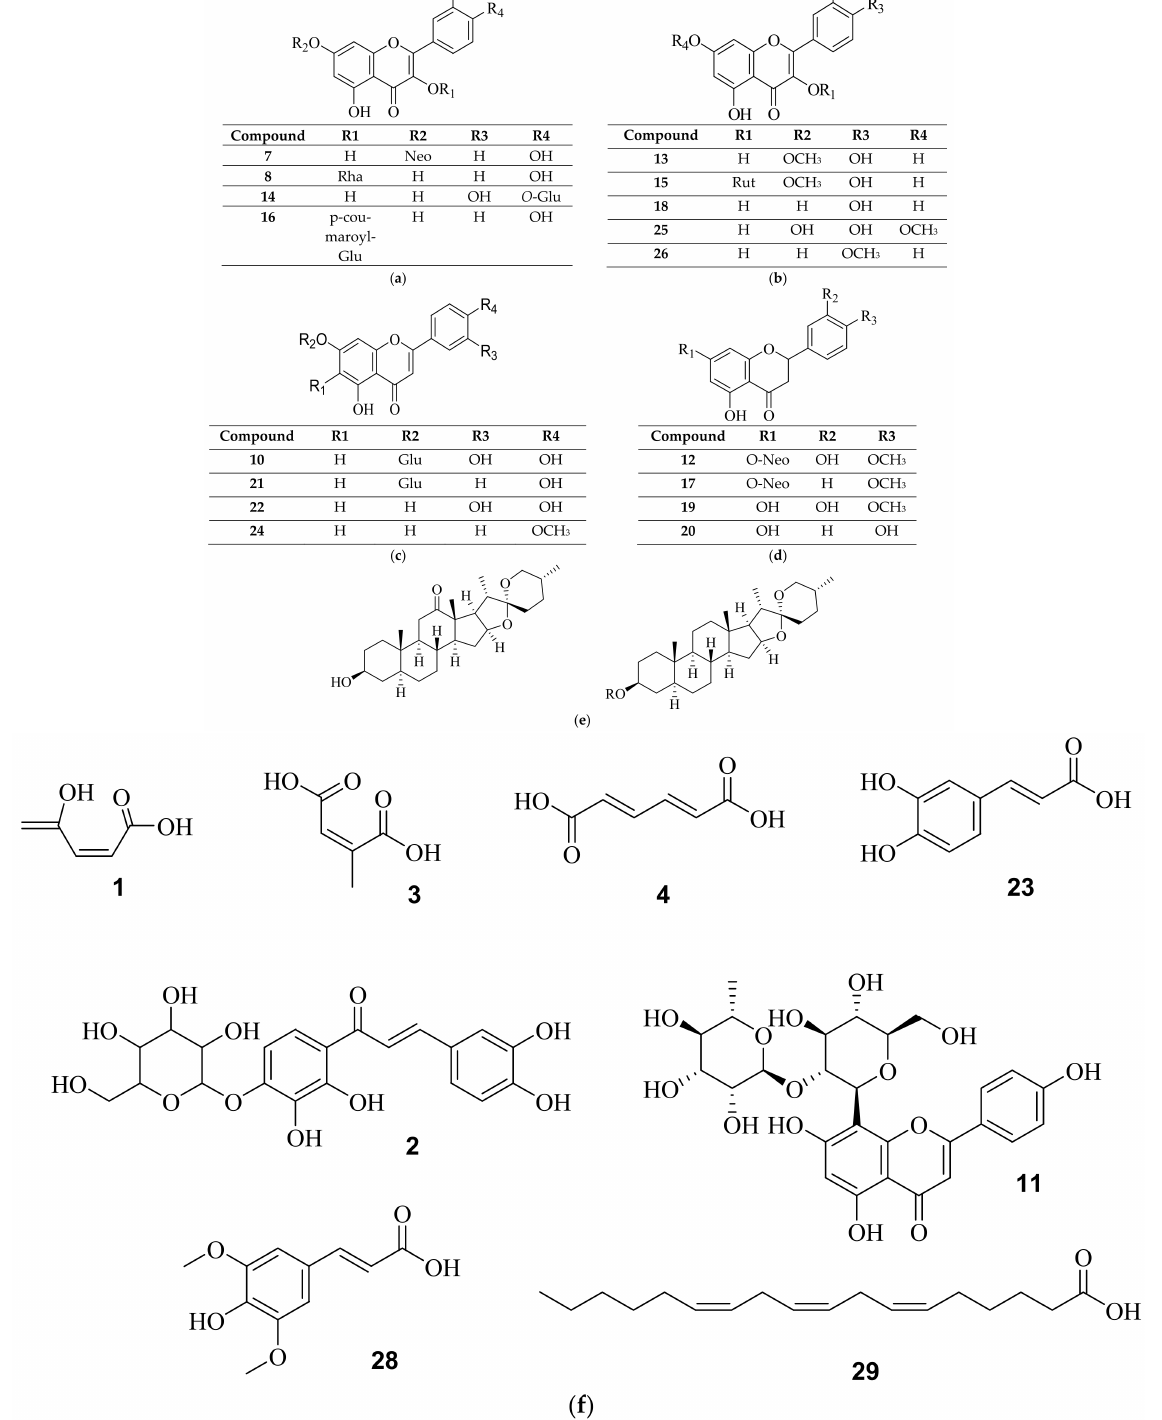
Figure 1. ( a ) Structures of flavonols and flavonol glycosides identified in YGME (Neo = neohesperido- side, Rha = rhamnose, Glu = glucose); ( b ) Structures of hydroxylated and/or methoxylated flavonols and flavonol glycosides identified in YGME (Rut = Rutinoside); ( c ) Structures of flavones and flavone glycosides identified in YGME; ( d ) Structures of flavanones and flavanone glycosides identified in YGME.; ( e ) Structures of saponin and saponin glycosides identified in YGME ( 5 R = Glu-Gal, 9 R = Glu-Glu, 27 R = OH).; ( f ) Structures of organic, phenolic acids, and other compounds identified in